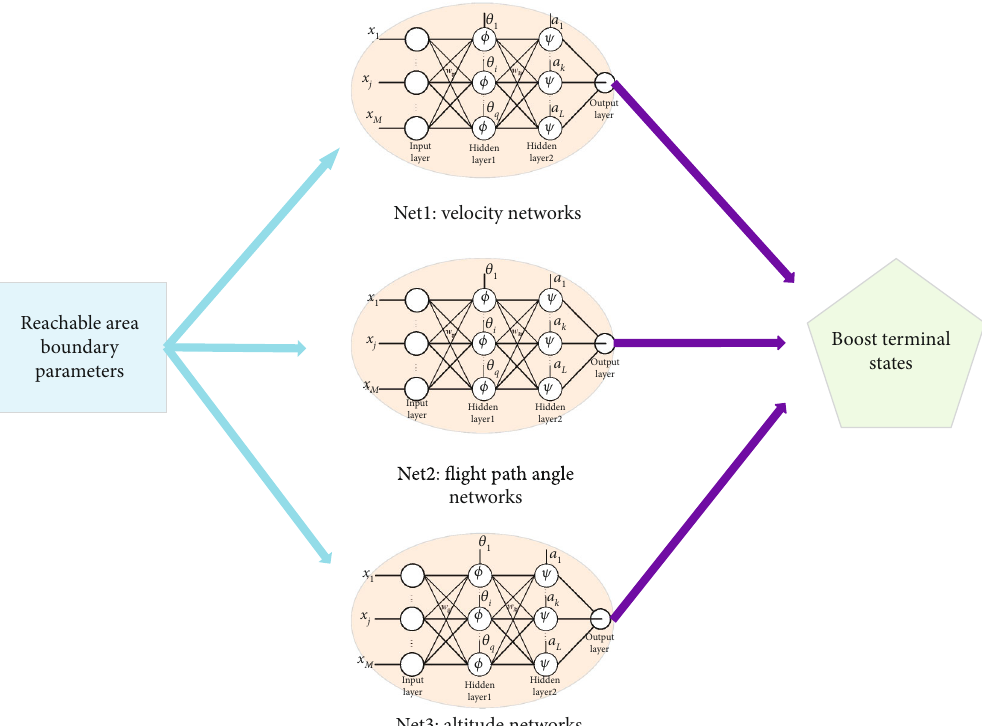
Figure 7: Relational mapping diagram of deep neural